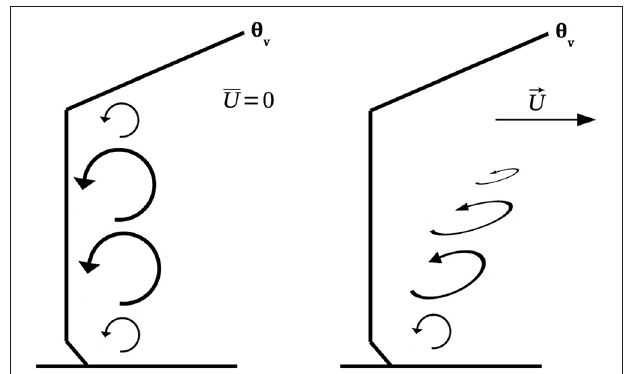
FIGURE 2 | Schematic view of the effect of stratification and vertical wind shear on the reduction of the vertical mixing efficiency. Without wind shear (Left) , the turbulent structures are constrained by the distance to the surface and by the stratification. The presence of a wind shear (Right) results in the stretching and decoupling of the turbulent